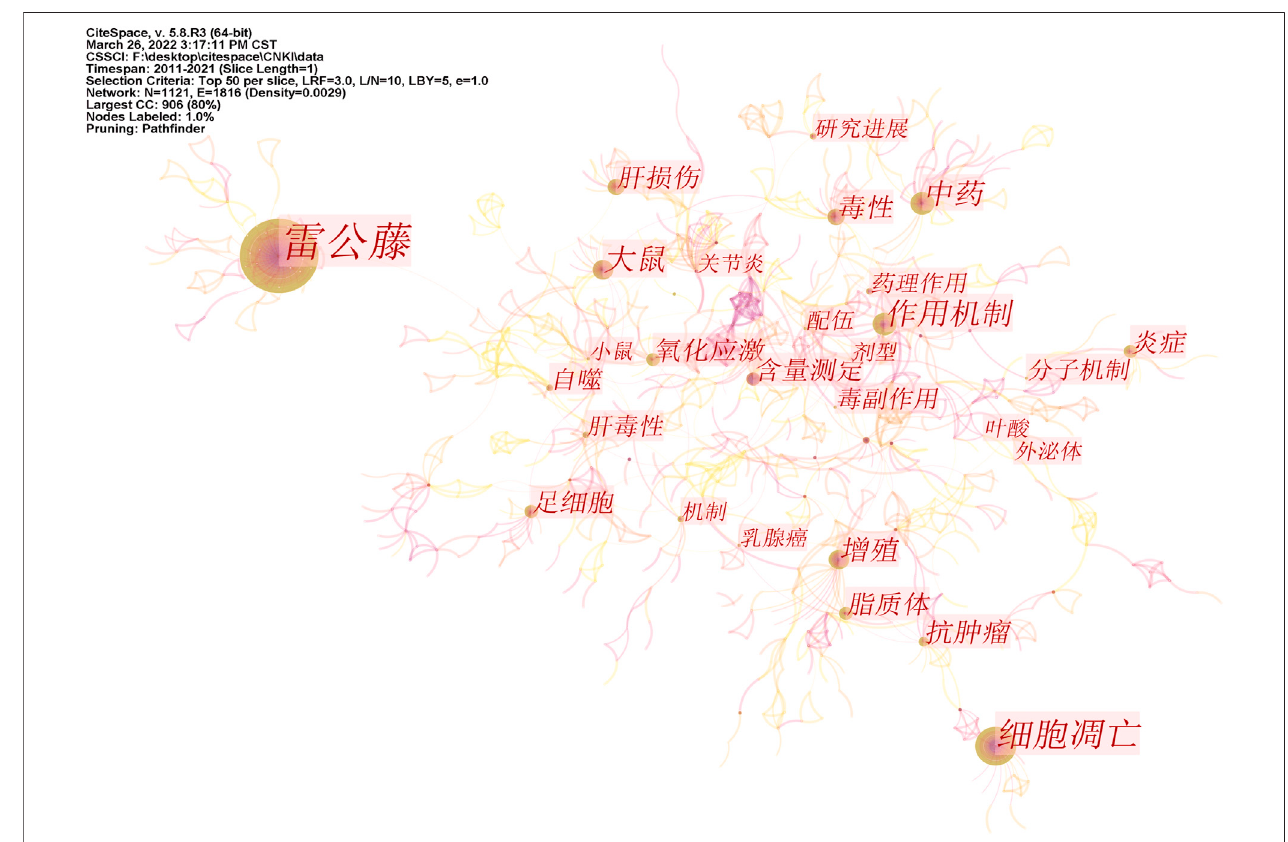
FIGURE 6 | Co-occurrence network of triptolide literature keywords from the